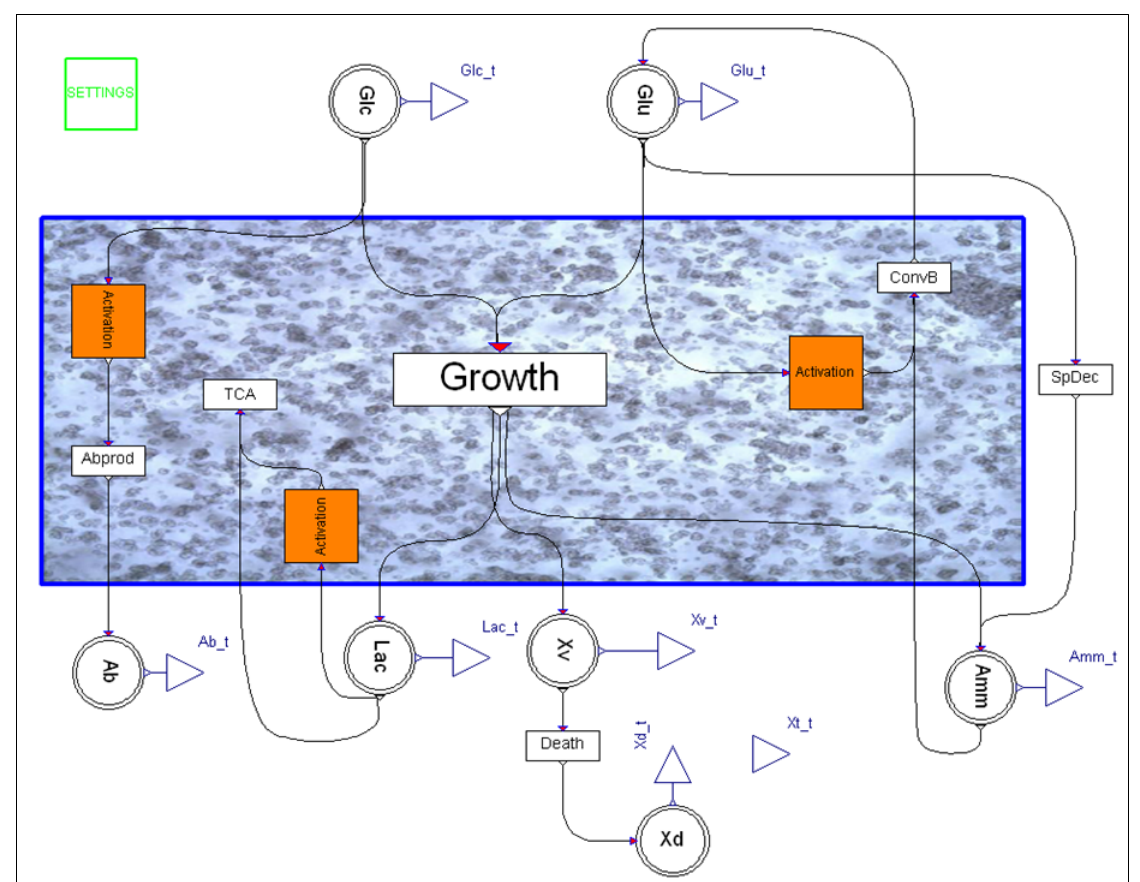
Figure 25: Petri Net model of the main CHO-metabolism in Dymola.